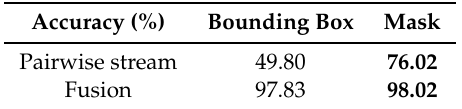
Table 1. Pairwise stream performance comparison.